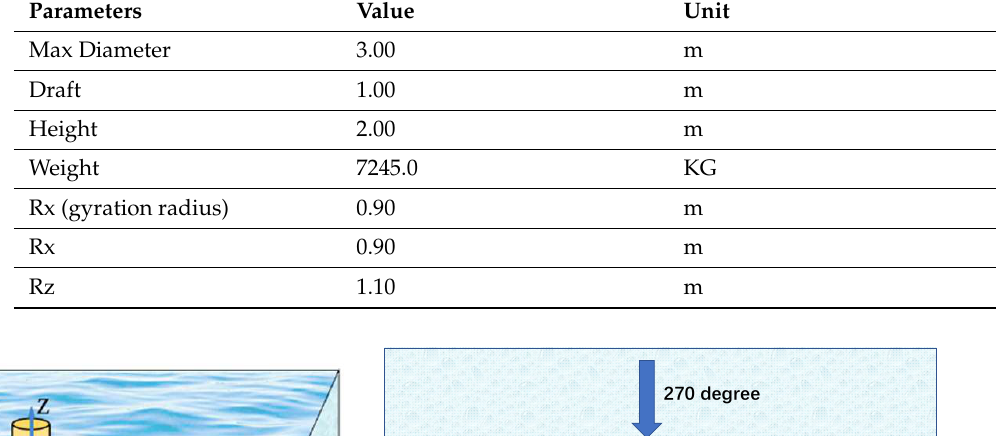
Table 1. Main particulars of the foundation. Table 3. Properties of mooring lines.